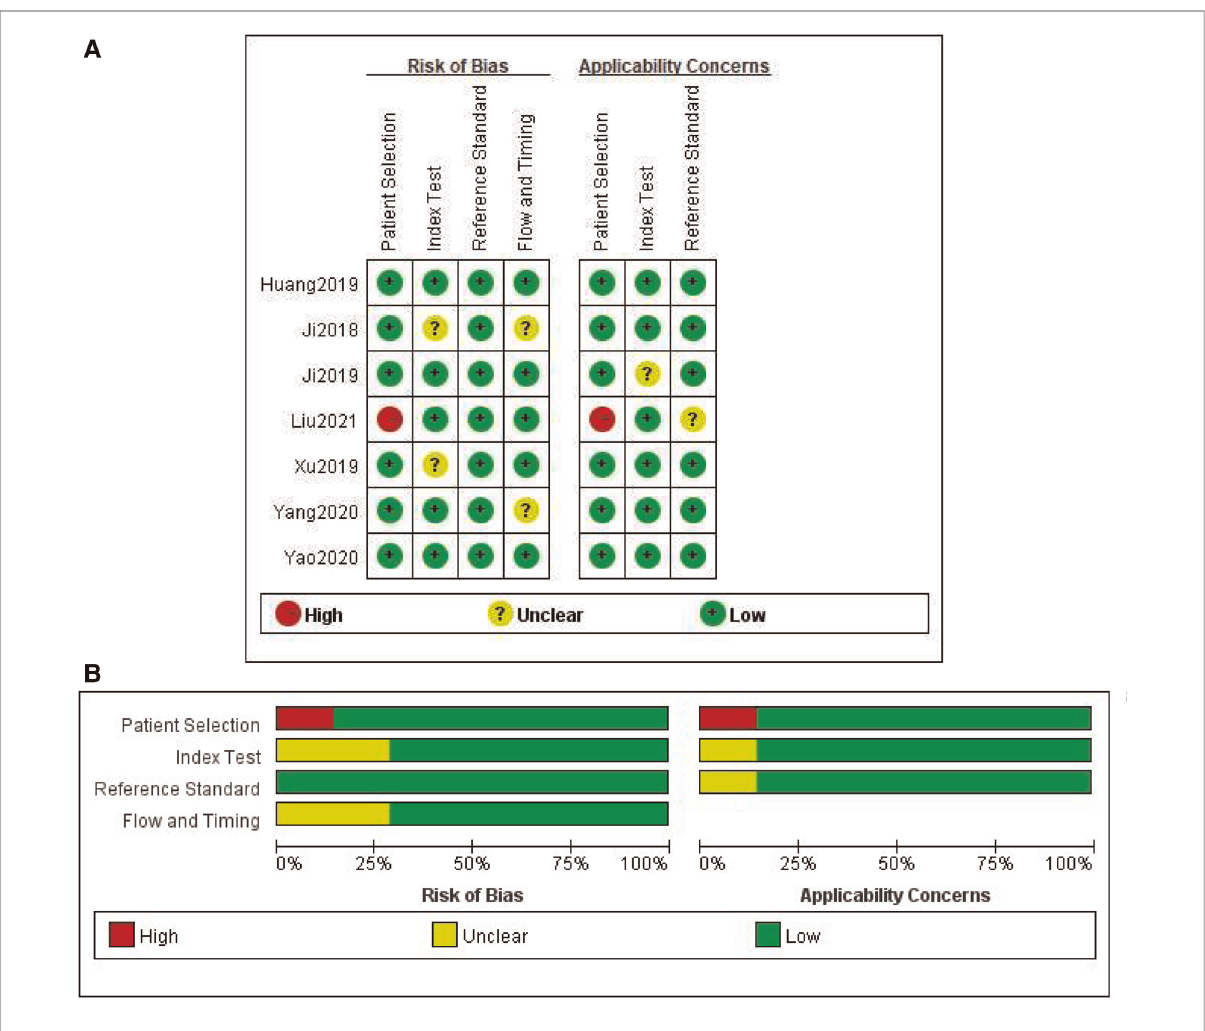
FIGURE 2 Methodological quality assessment of the included studies based on the QUADAS-2 scale. ( A ) Individual studies, ( B )